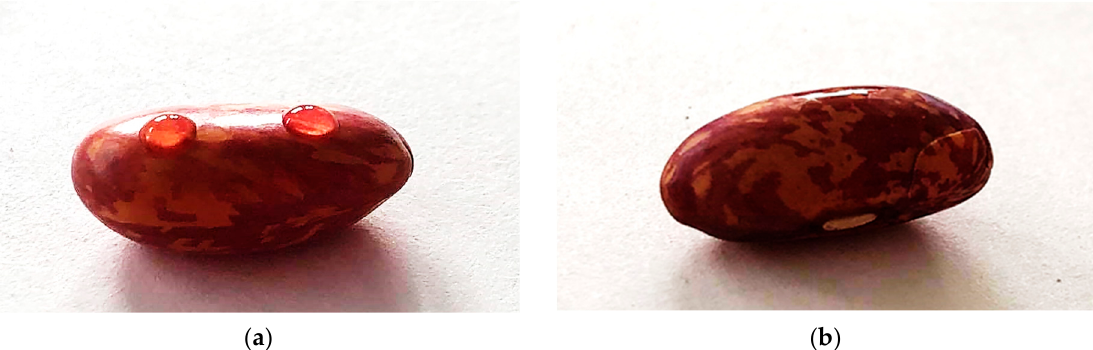
Figure 2. Water droplets on the surface of ( a ) an untreated bean seed and ( b ) a bean seed treated by plasma at t = 3 s, p = 10 Pa.